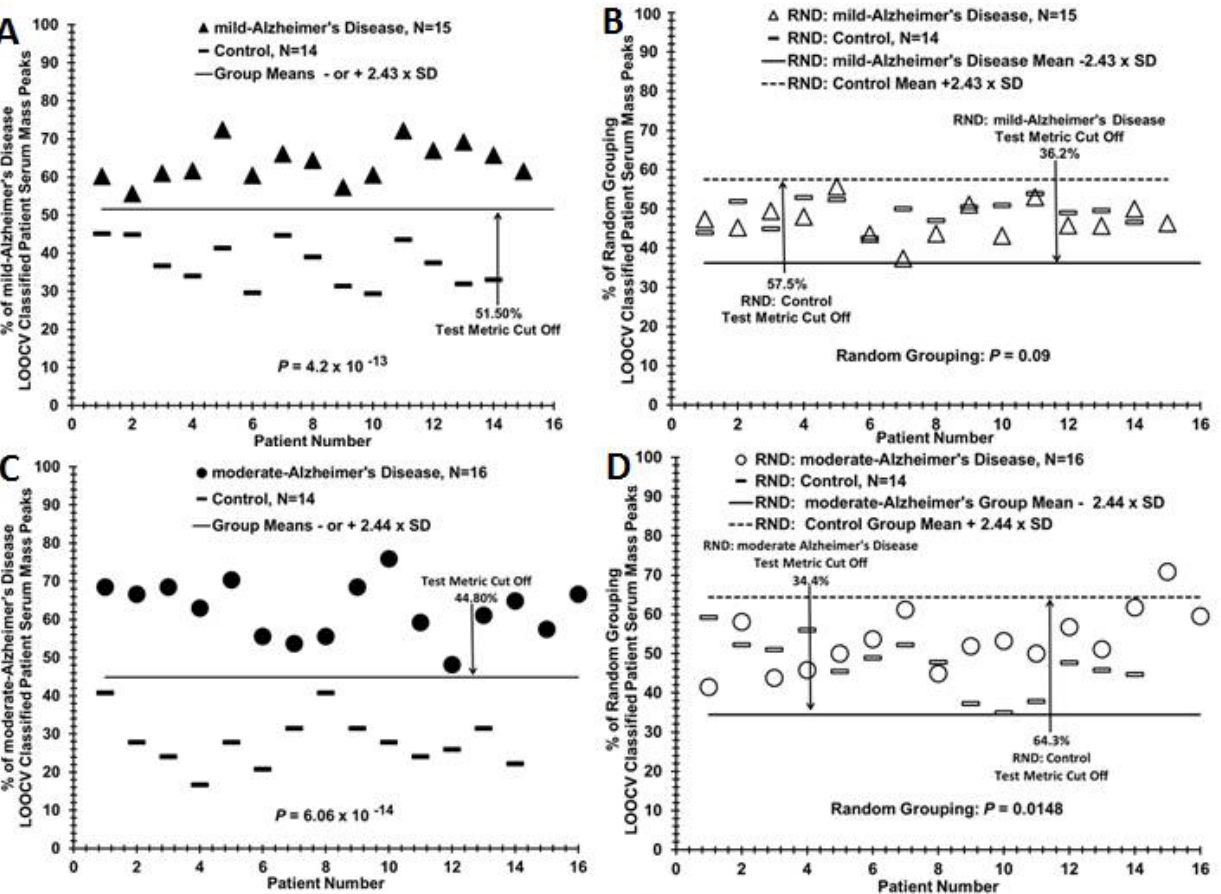
Figure 2. Distinguishing sera of mild or moderate AD patients from control individuals by MS serum mass profiling ( A ) Serum discrimination of mild AD patients (dark triangles) from controls (dashes) by % of LOOCV/PCV classified mass peaks. A cut off value is present (− or + SDs from the mild AD or control groups, respectively) to determine test metric values (e.g., true positives). ( B ) Non-serum sample discrimination when the two different sample groups in A are mixed together randomly followed by the same LOOCV/PCV mass peak analysis. ( C ) Serum discrimination of moderate AD patients (dark circles) from controls (dashes). ( D ) Non-serum discrimination upon randomization of sera samples between the two groups in C followed by the same LOOCV/PCV analysis.